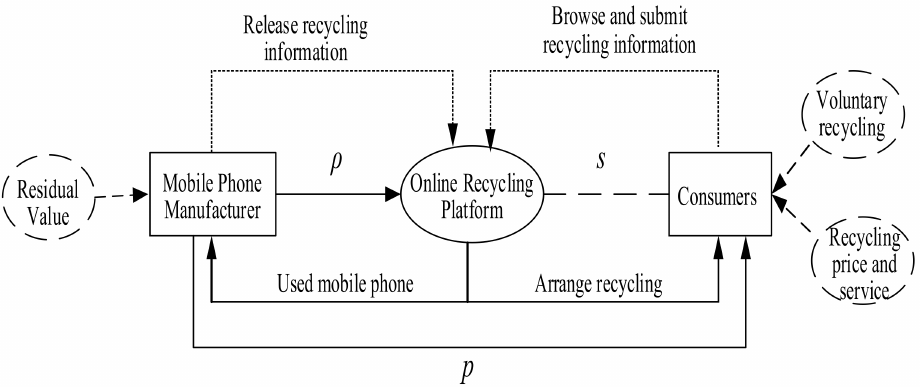
Figure 1. The online reverse supply chain model of used mobile